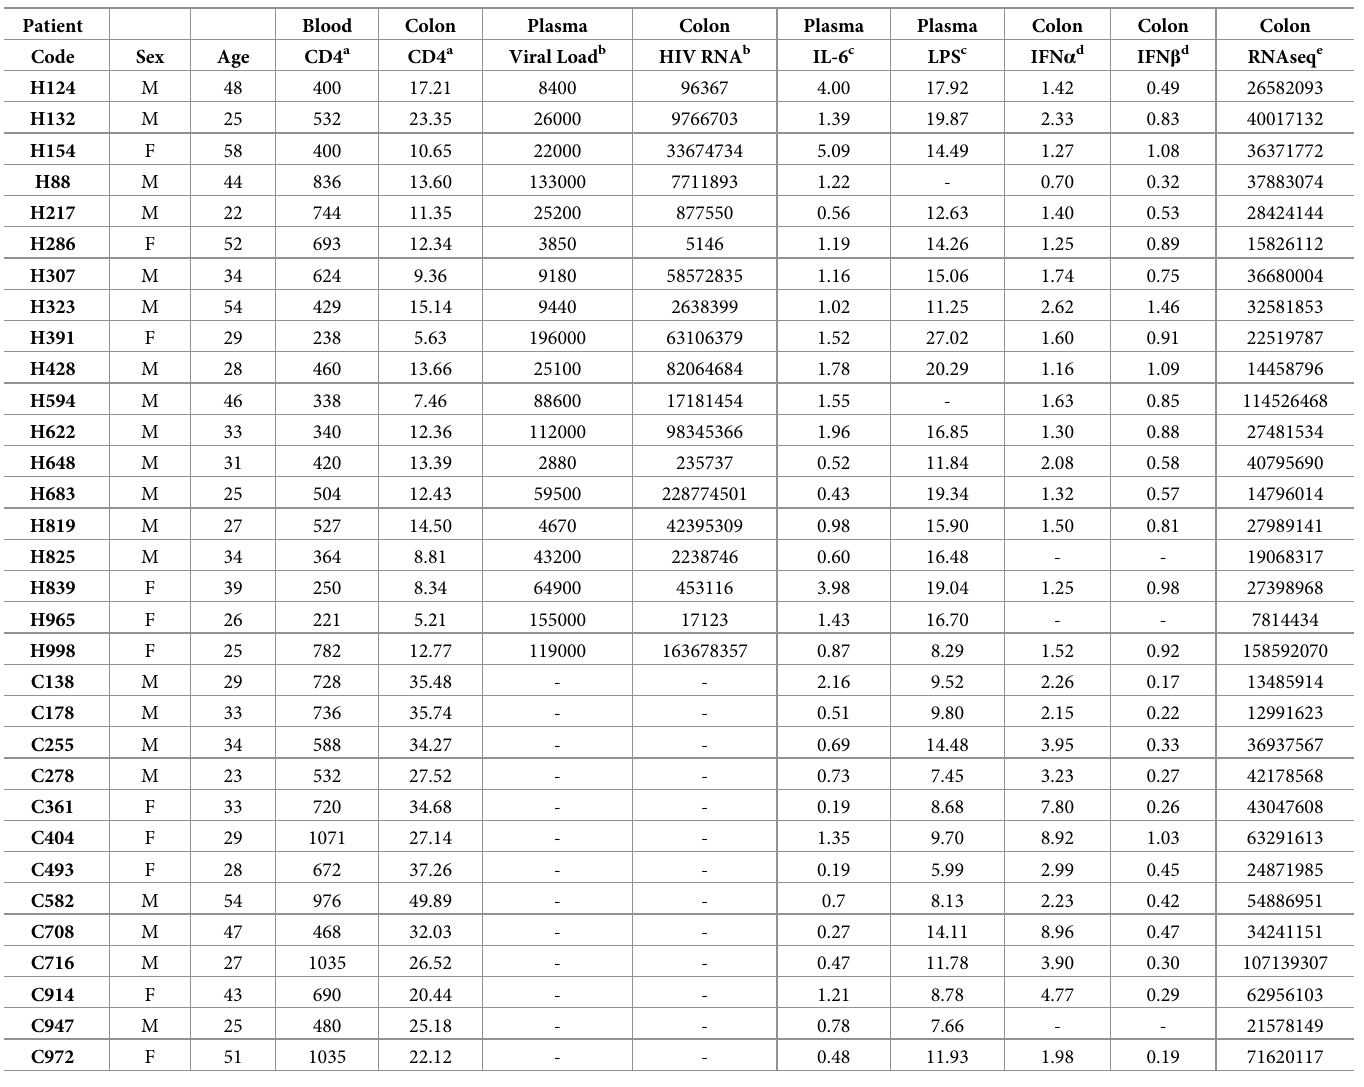
Table 1. Clinical Cohort of PWH versus HIV Uninfected Controls for Interferome Profiling.